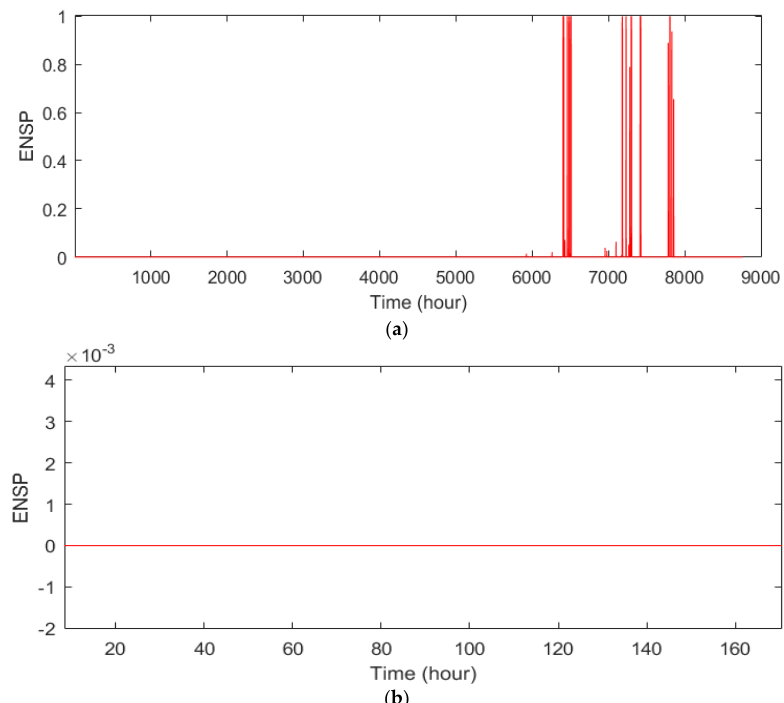
Figure 11. ENSP in the sizing of the HPV/FC energy system via the IAEO, considering ENSP max = 1% during ( a ) a year and ( b ) a week.